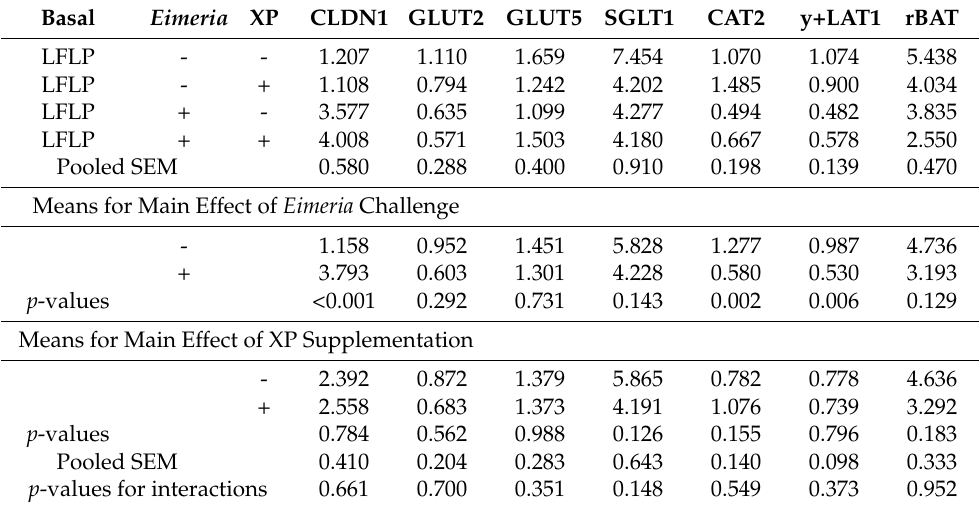
Table 7. Effects of mixed Eimeria spp. infection and exogenous enzymes on gene expression of tight junctions and nutrient transporters of jejunum in broiler chickens on 6 days post infection (LFLP; Expt.